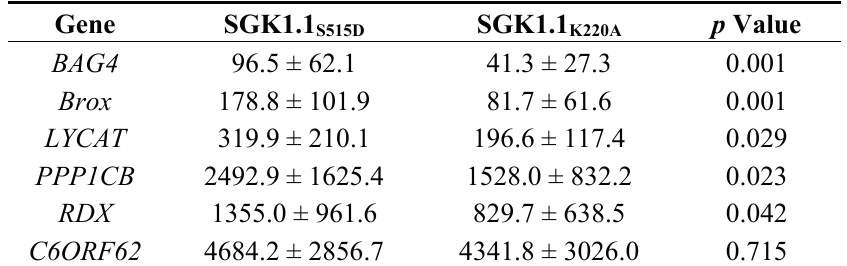
Table 1. Quantification of mRNA expression of identified genes by qRT-PCR in transfected HeLa cells. Mean ± standard deviation for BAG-4 , Brox , LYCAT , PPP1CB , RDX and C6ORF62 gene expression levels are expressed as ×10 5 relative to β -actin expression in SGK1.1S515D (active) and SGK1.1K220A (non-active) transfected